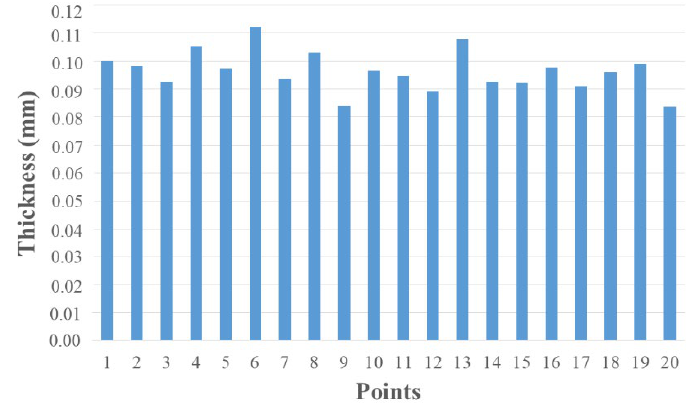
Figure 4. Thickness distribution for LDPE-100.